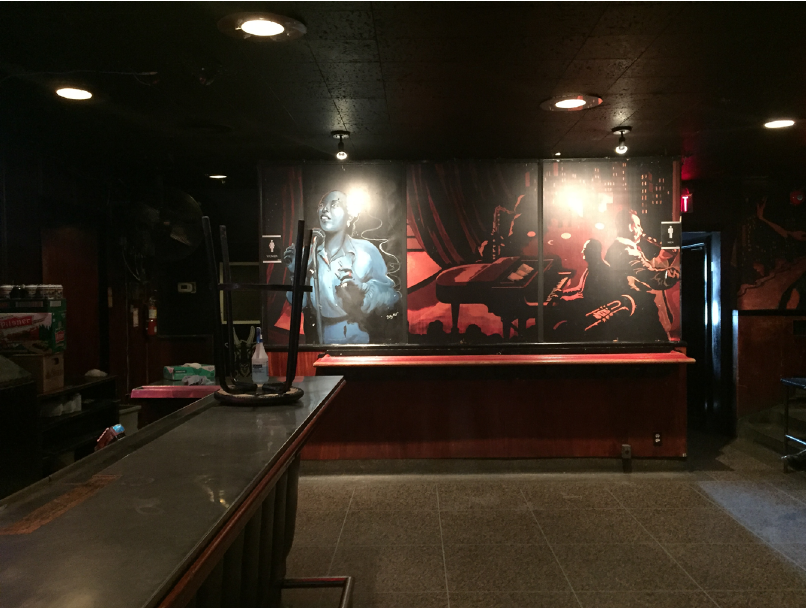
Figure 4. Example of mural work on the interior walls of the Silver Dollar Room. This mural is located on the rear wall of the space and features jazz musicians playing beside a female